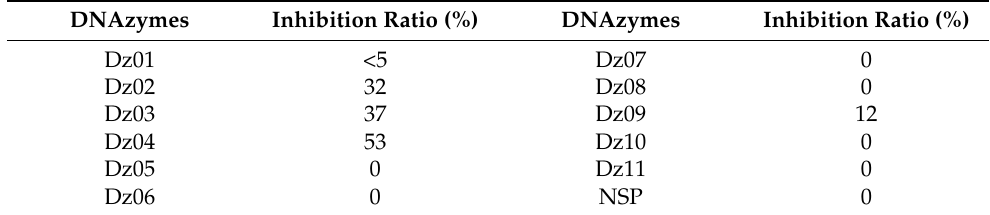
Figure 2. Finding the DNAzyme with gene-silencing activity in cells. ( a ) In vitro cleavage study of twelve Dz8–17 DNAzymes via agarose gel analysis. All reactions were carried out under simulated physiological conditions (150 mM KCl, 0.5 mM MgCl 2 , pH 7.5) at 37 ℃ for 2 h. s: substrate; P1: product 1; P2: product 2. ( b ) EGFP gene-silencing study with the DNAzymes in cells. The fluores- cent data were collected 48 h after transfection and reported as mean value ± SD of three repeats. The transfection concentrations of the DNAzymes were 400 nM, and Mock was a negative control using ultrapure water instead of a DNAzyme. NSP: negative DNAzyme control with nonspecific arm sequences. Each DNAzyme and control were labeled with different colors. Table 2. The inhibition ratios of 11 DNAzymes targeting EGFP mRNA and NSP control.